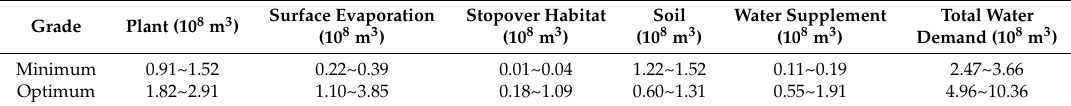
Table 6. Total water demand in study area.